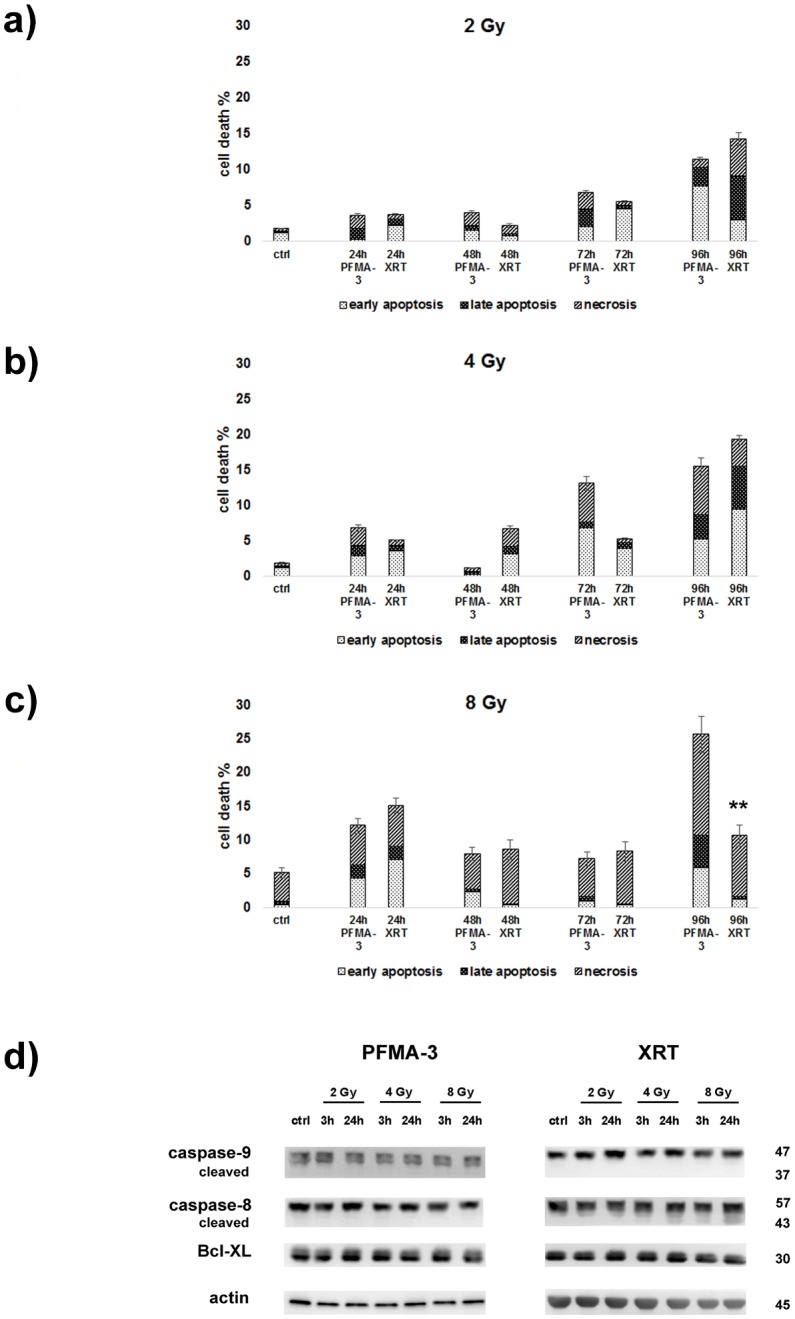
PFMA-3 and XRT treatments did not induce significant apoptotic events until 96 hours.Flow cytometric analysis of Annexin V-FITC/PI-stained SK-Mel28 cells treated with a) 2 Gy b) 4 Gy c) 8 Gy PFMA-3 and XRT at different time points. The percentages of early apoptotic cells (Annexin V FITC+/PI-), late apoptotic/necrotic cells (Annexin V FITC+/PI+) and necrotic cells (Annexin V FITC-/PI+) were plotted. The histograms were representative of three separate experiments. Asterisks indicated statistically significant differences (**P <0.005). ctrl, control cells. d) Western blot analysis documenting some apoptotic marker levels modulation in PFMA-3 and XRT irradiated samples. Antibody to b-actin served as a loading control. ctrl, control cells.